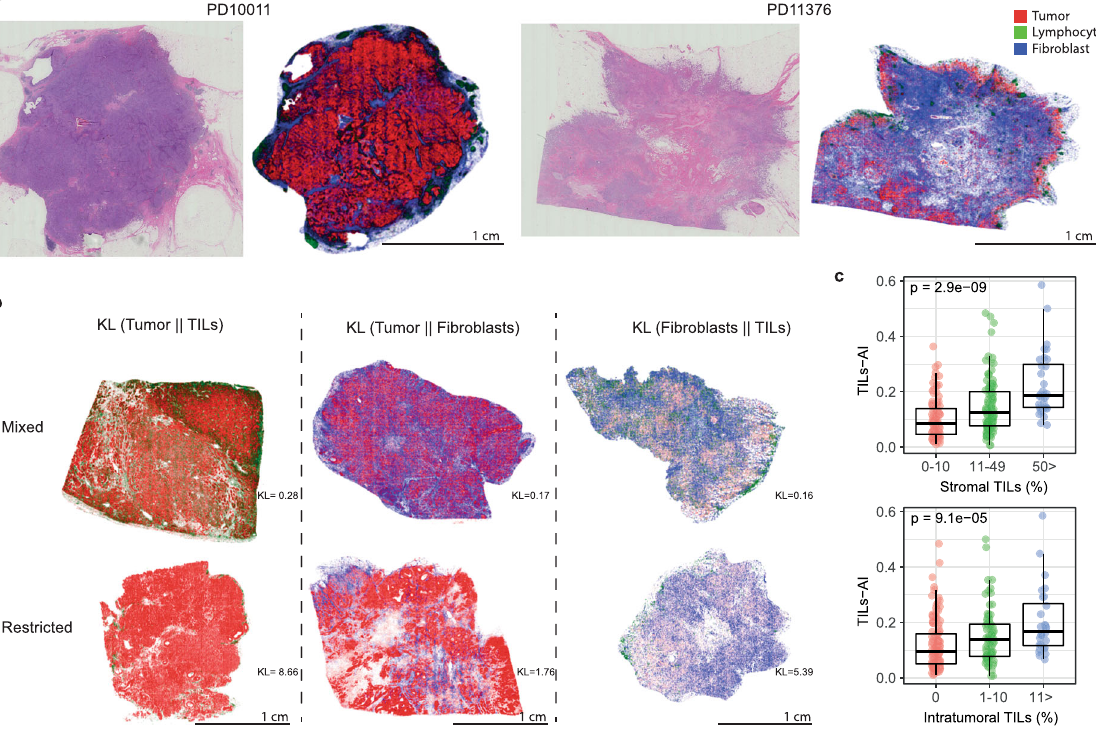
Fig. 2 Cell detection and classi fi cation results of ICGC cohort. a Examples of the cell detection and classi fi cation results of 2 H&E images. b Examples images of H&E images with mixing or restriction of cell types. c The TILs-AI in ICGC breast tumors ( N = 235) grouped by increasing levels of intra-tumoral or stromal TIL fraction (0 – 1) scored by pathologists (Kruskal – Wallis test). Scalebar for each image is 1 cm.